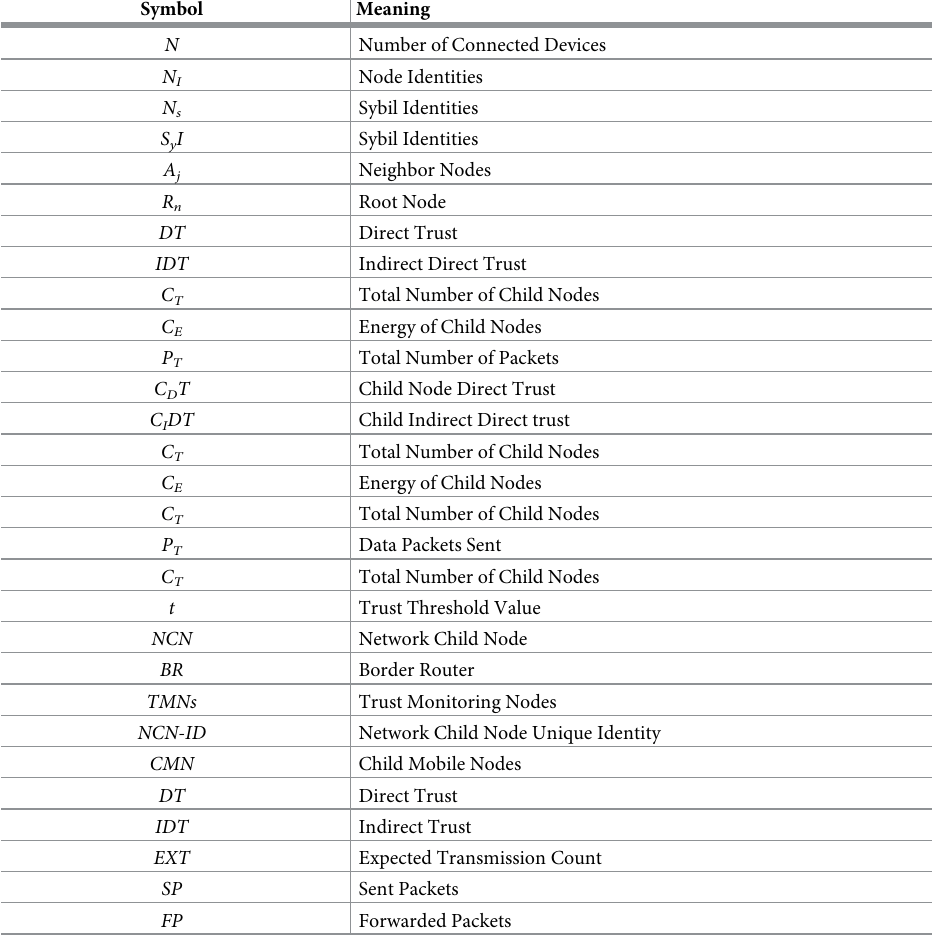
Table 1 represents a summary of nomenclature used in the paper. Table 1. Summary of